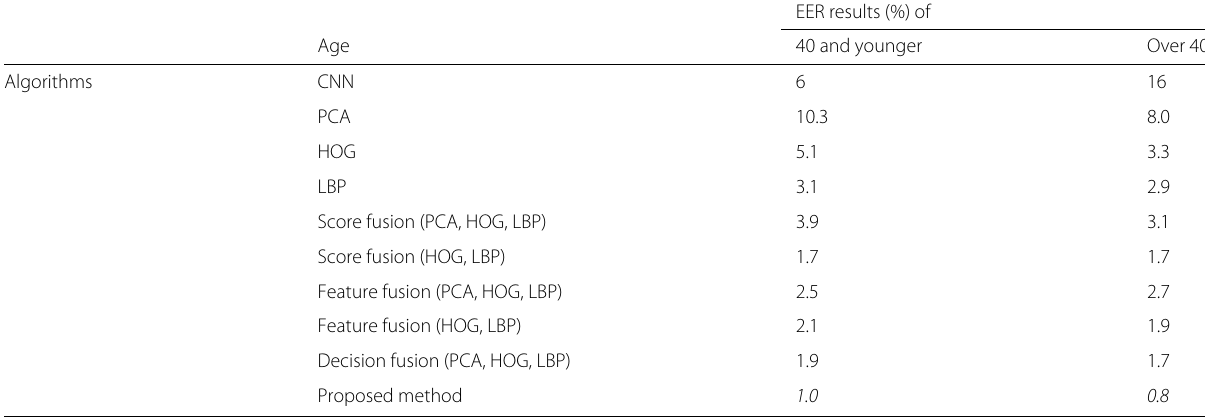
Table 9 EER results of age-based experiments for non-twins